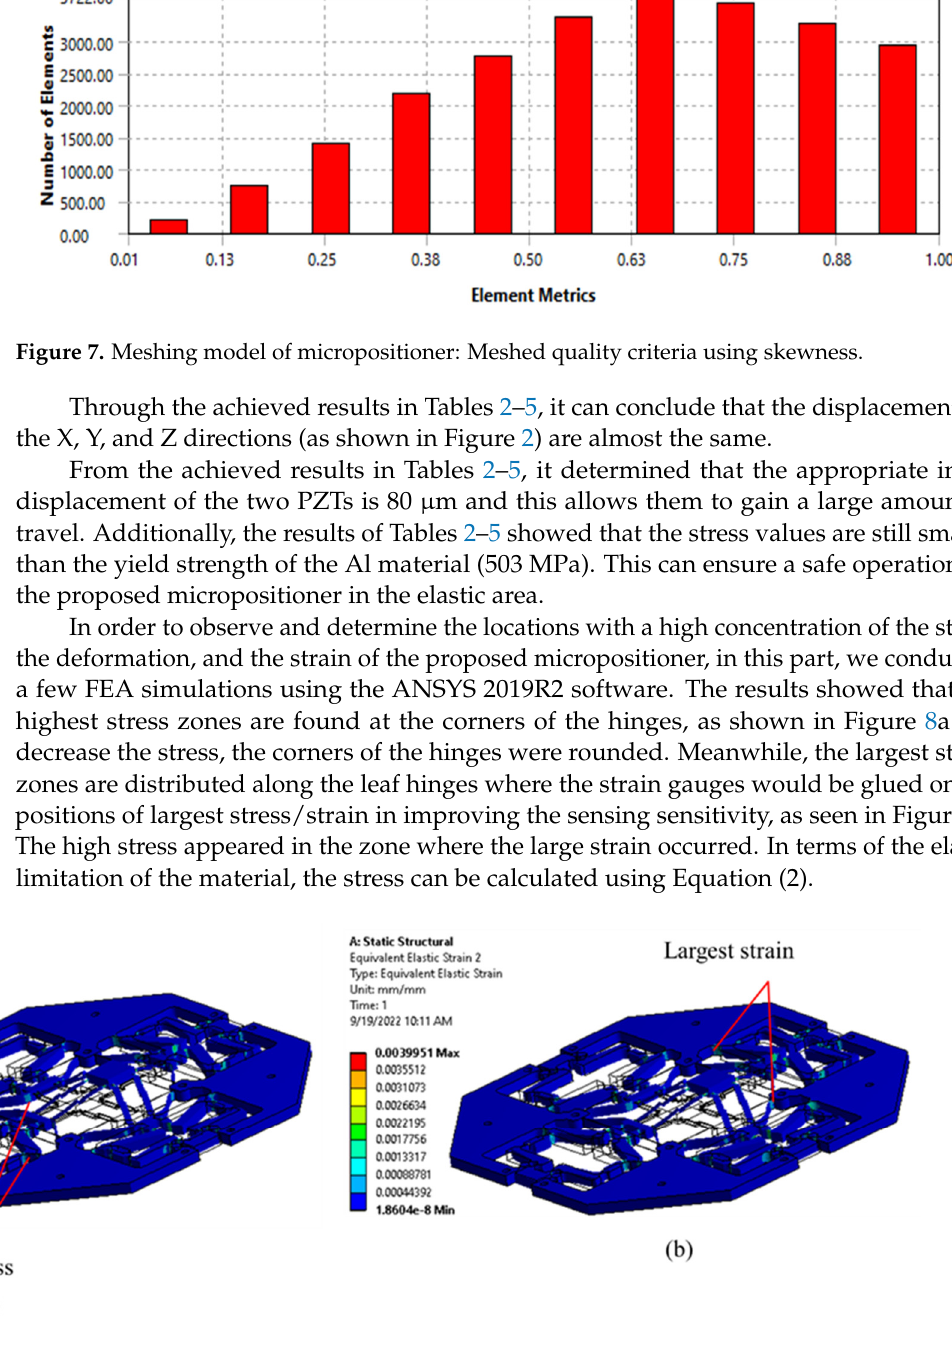
Note: F 1 and F 2 represent the safety factor and the output displacement, respectively. Table 5. Numerical results (Input displacement of 80 µm).